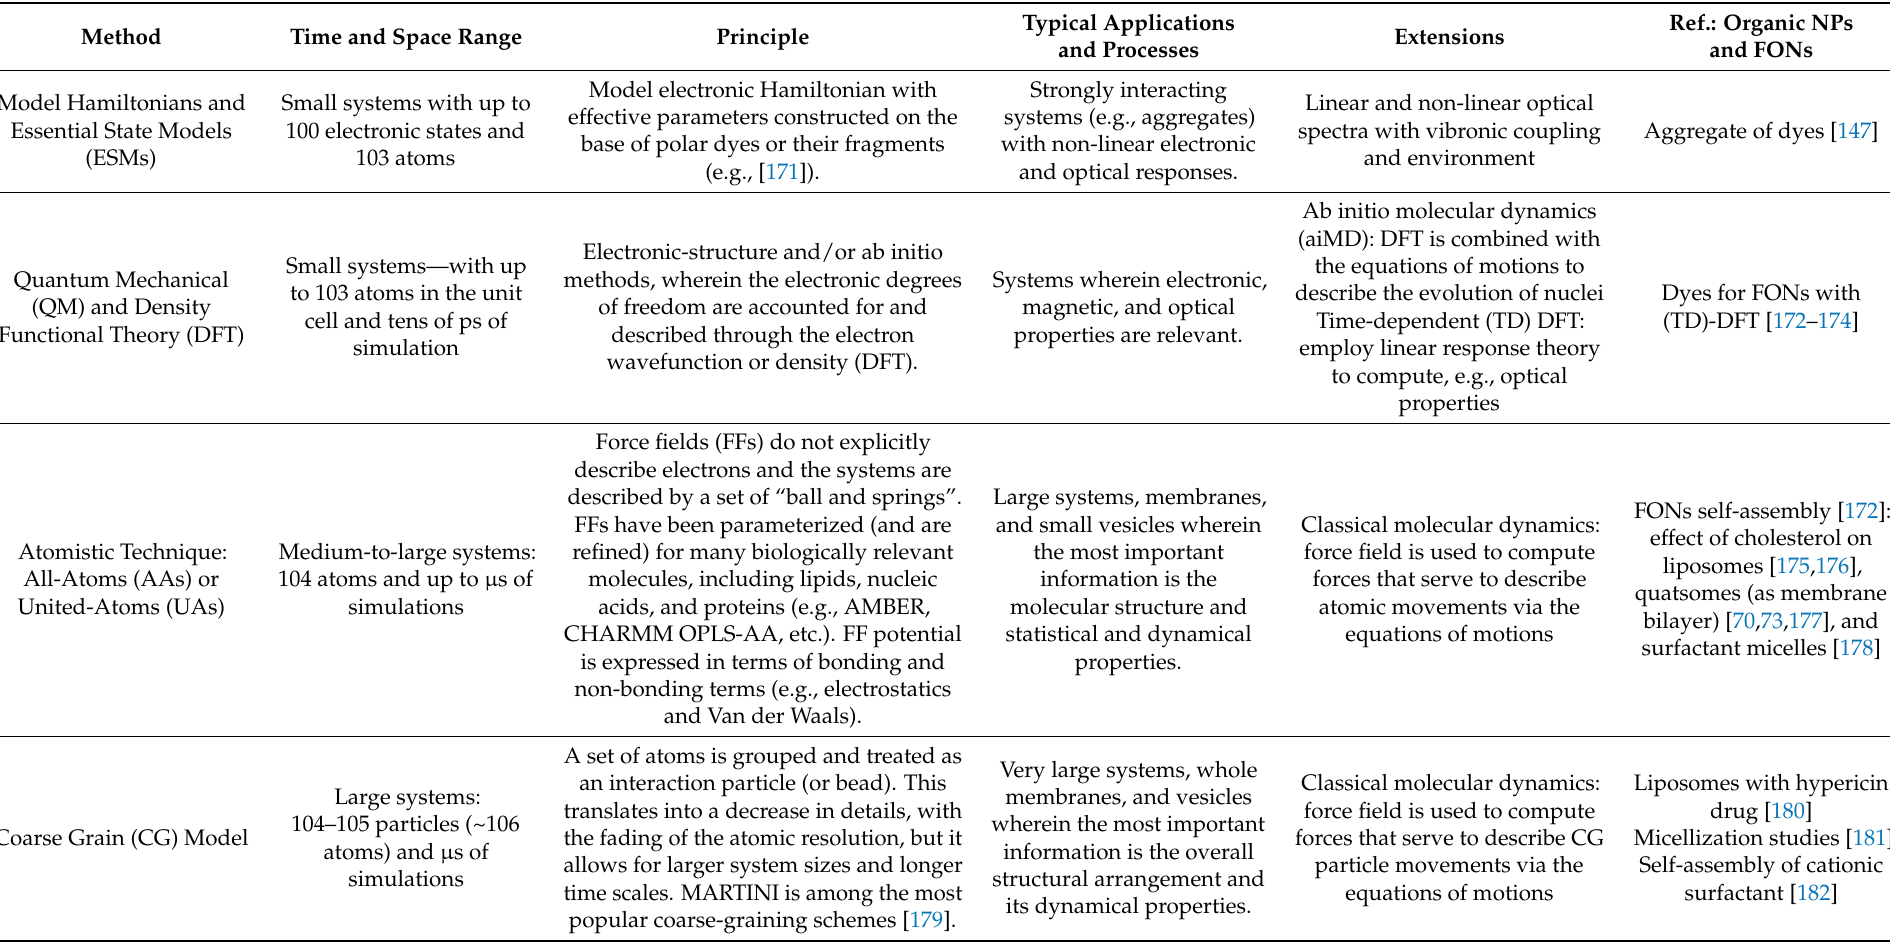
Table 3. Summary of the current approaches for simulating the organic NPs and